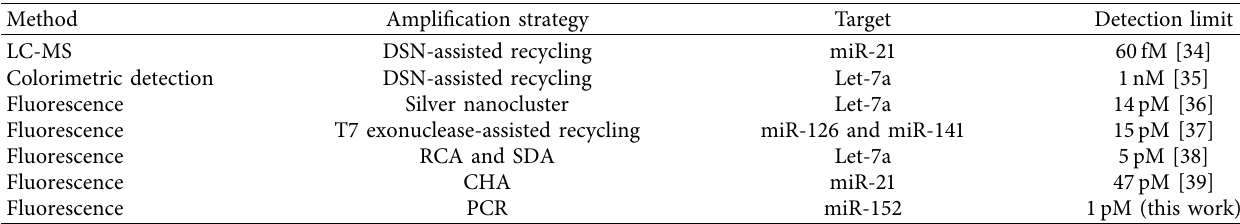
Figure 6: △ Ct values (a) and fluorescence intensities (b) for target miR-152 detection. Experiment conditions: forward primer was 4 μ M; reverse primer was 2 μ M; mediator template was 50 nM; and Tm was 42 ° C. The detection procedure was carried out as described in the experiment section. Table 2: Comparison of sensitivities for different miRNA assay methods.